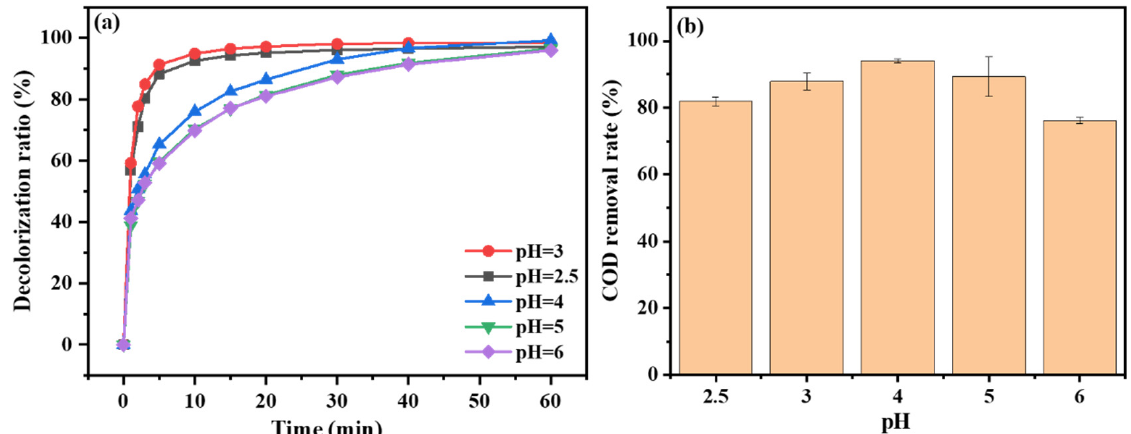
Figure 7 . Effect of different pH on the ( a ) decolorization rate of ARG and ( b ) COD removal rate in the Fe 3+ /H 2 O 2 /CSPAC system (0.1 mmol/L FeCl 3 , 0.4 mmol/L H 2 O 2 , 100 mg/L ARG, 0.6 g/L CSPAC (75 μ m particle size), pH = 2.5–6).